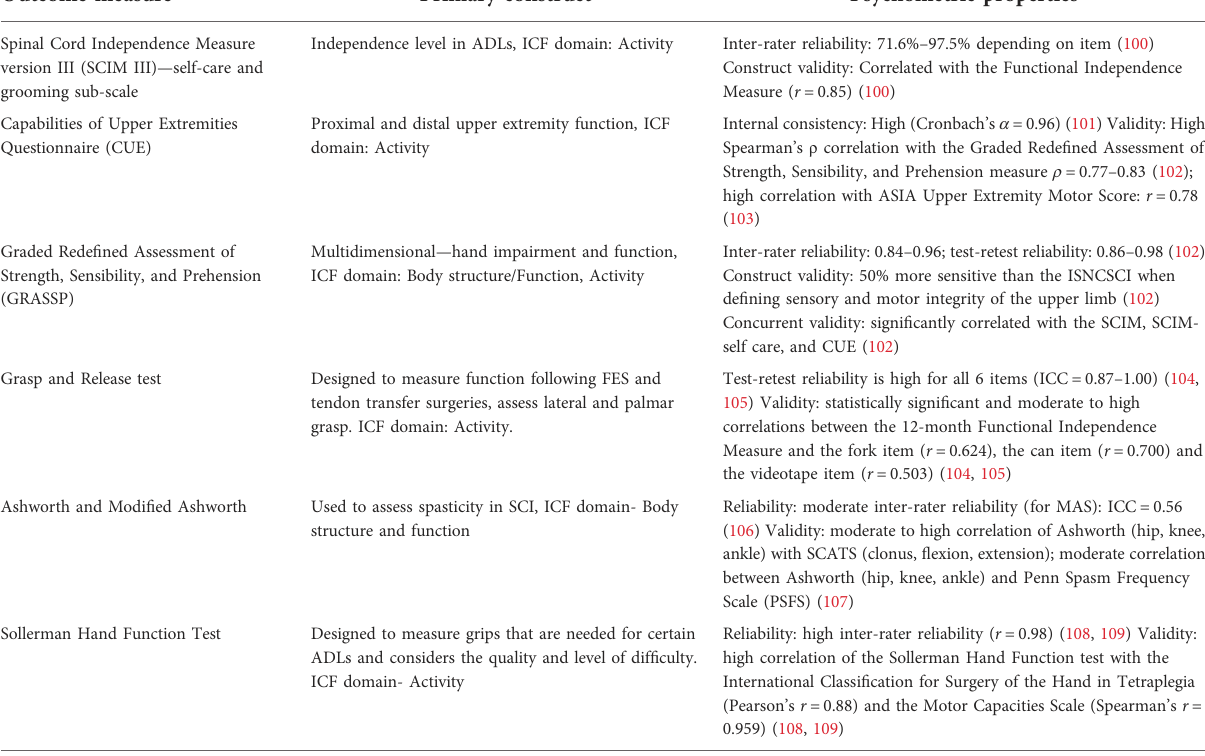
TABLE 1 Clinical measures of upper extremity function and their psychometric properties in individuals with spinal cord injury. Outcome measure Primary construct Psychometric